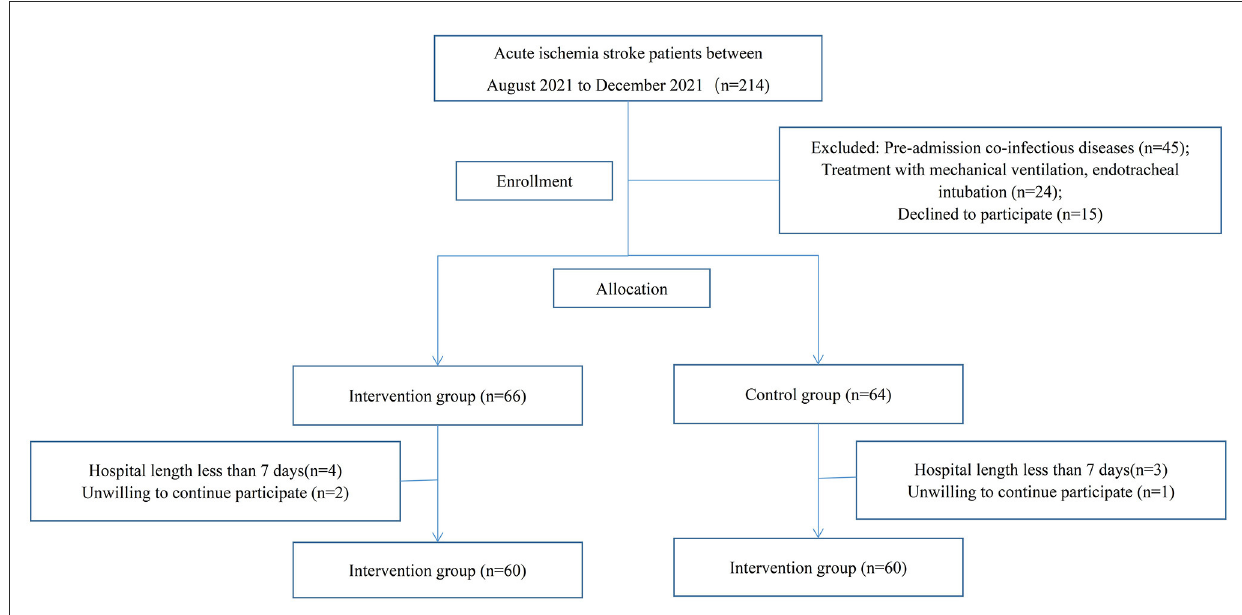
FIGURE1 Flowchart showing recruitment and dropout of